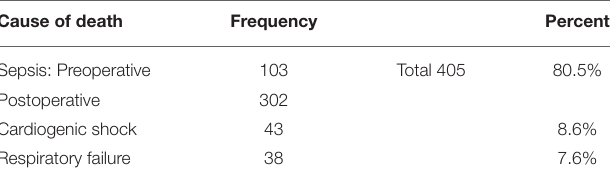
TABLE 2 | Common causes of death.